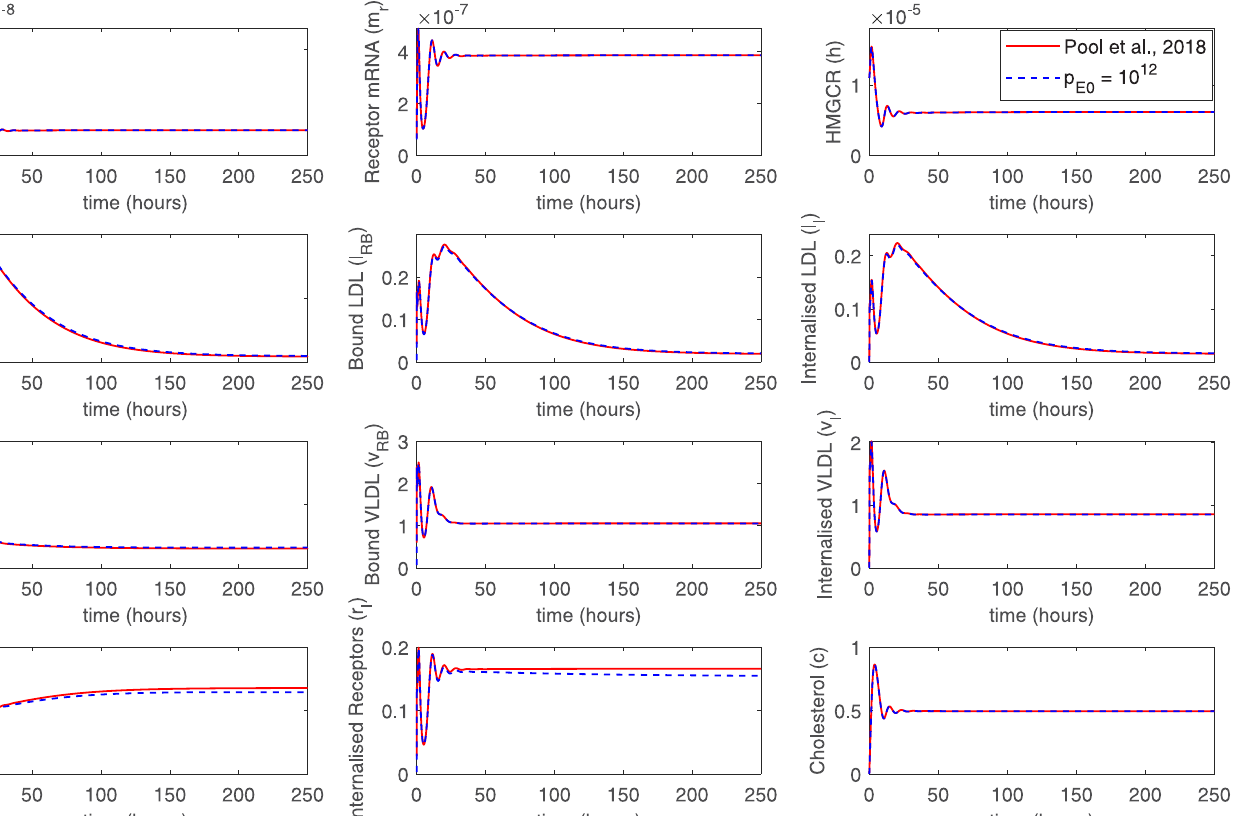
PLOS ONE | https://doi.org/10.1371/journal.pone.0264903 June 3,